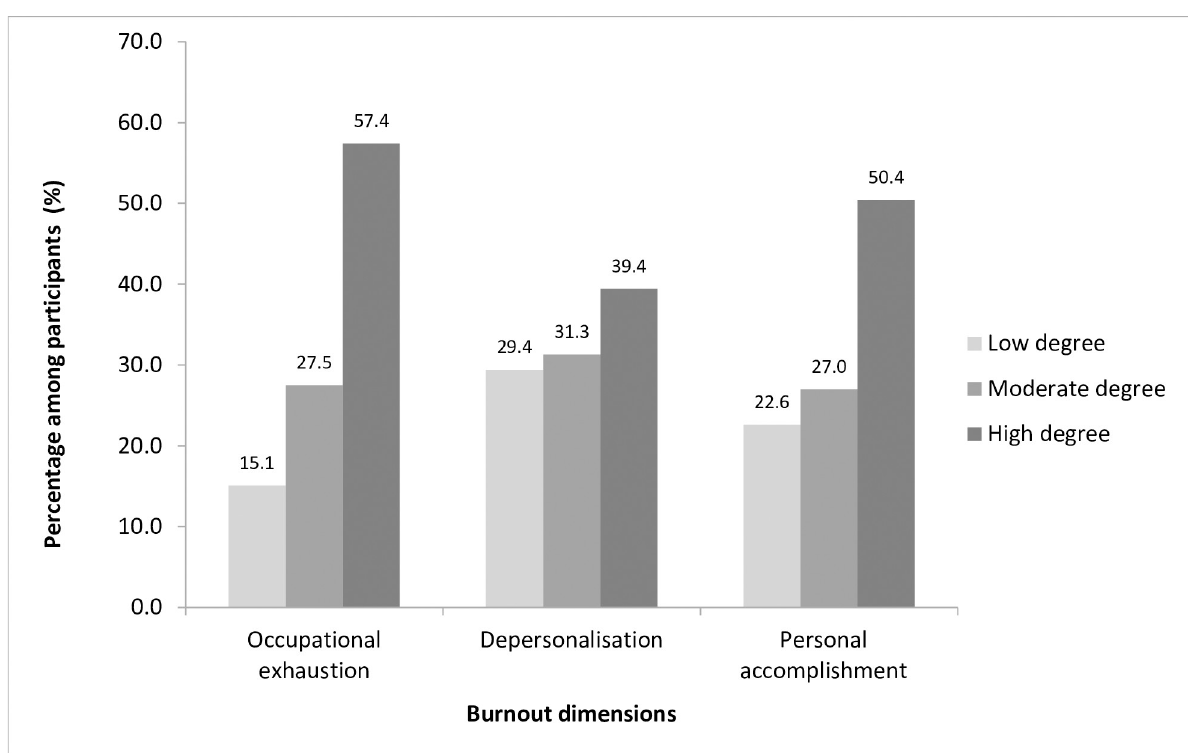
Fig 3. Distribution of burnout dimensions levels among participants. https://doi.org/10.1371/journal.pone.0282318.g003 PLOS ONE | https://doi.org/10.1371/journal.pone.0282318 March 23,